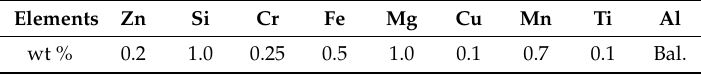
Table 1. Chemical composition of the Al6022-T43 alloy.